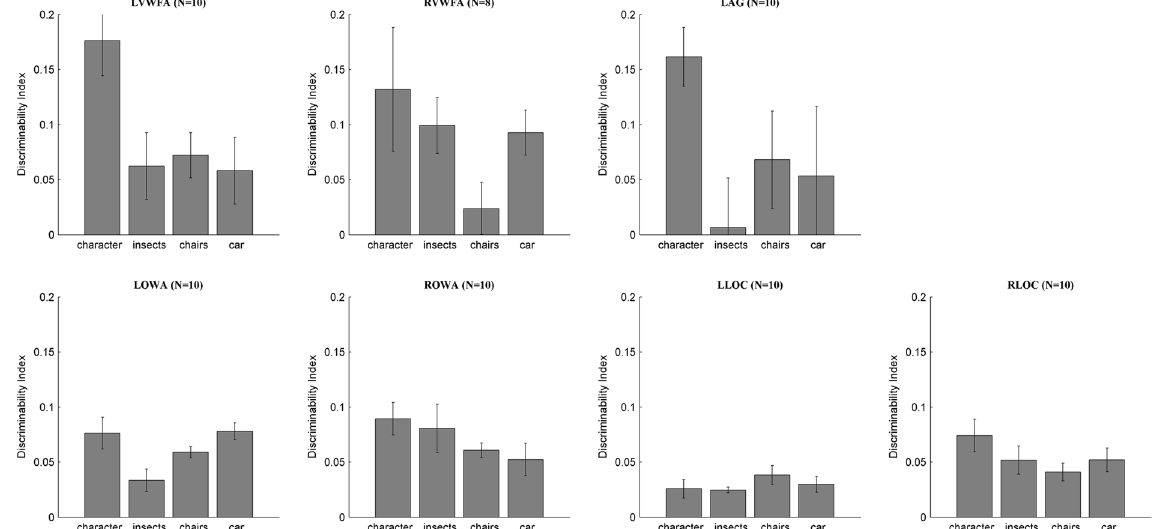
Figure 5. Discriminability index (DI) based on RSA from multivariate analysis. The DI reflects the ROI’s ability of discriminate one category from others, though each ROI could represent multiple categories. LOWA gained significantly less DI to character and was less specific to character comparing with LVWFA. The error bars denote the standard error calculated across subjects. (N: number of subjects) (the prefix “L” or “R” before each ROI name denotes left or